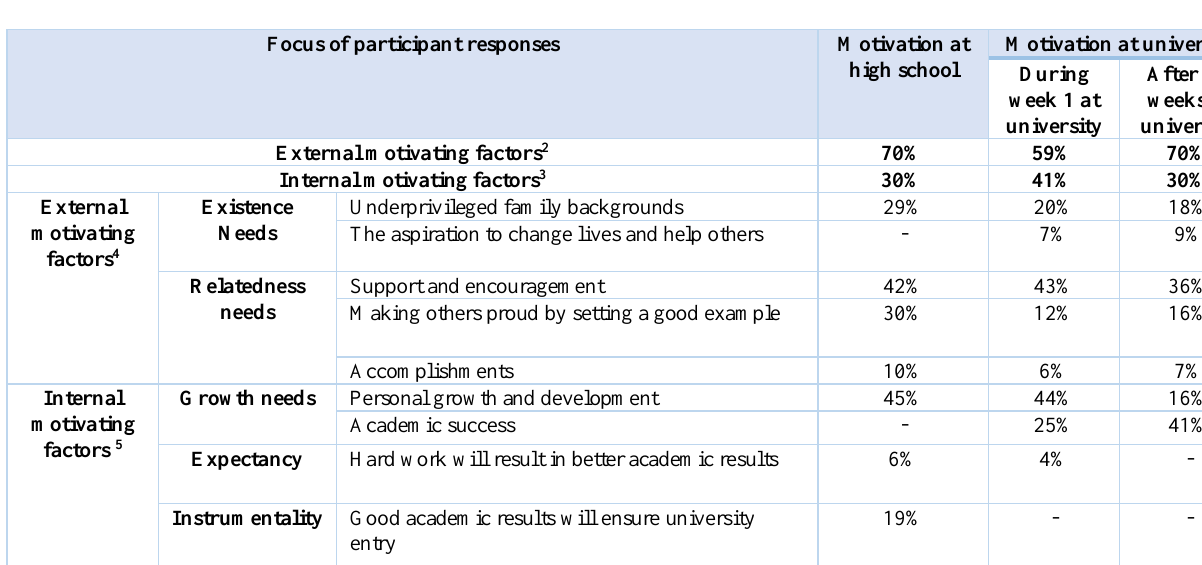
Results from the Data